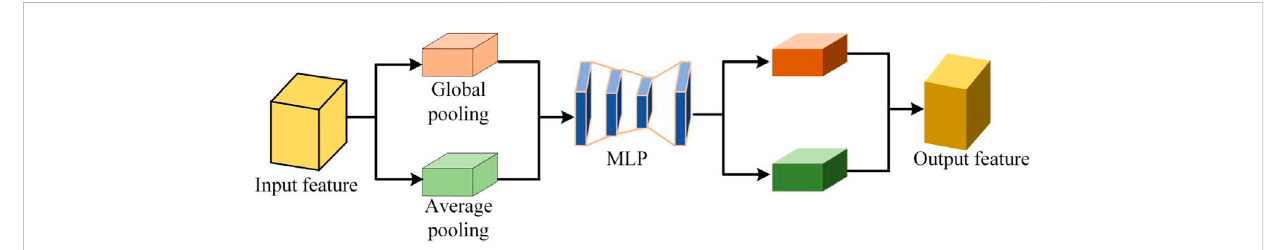
FIGURE 6 The module of global channel attention.